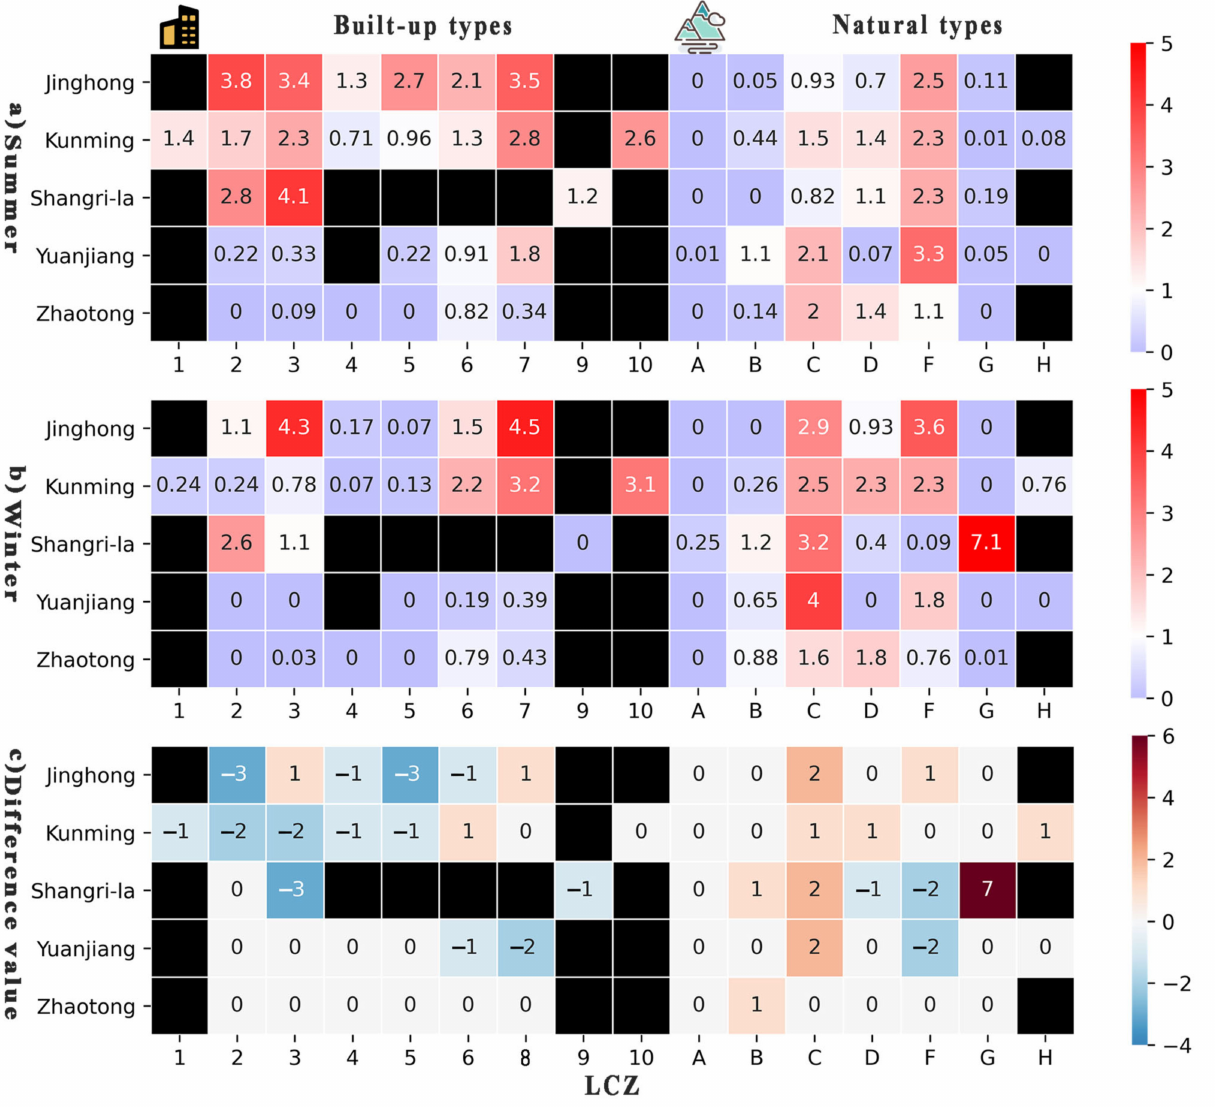
Figure 5. TDI values of each LCZ in summer ( a ) and winter ( b ) in the five cities with different background climates (black indicates no-data value, red indicates heating contribution, blue indicates cooling contribution, TDI values are shown in each box); ( c ) difference in the value of the thermal distribution index (TDI) between winter and summer (black indicates no-data value, red and blue indicate the increase and decrease of TDI values from summer to